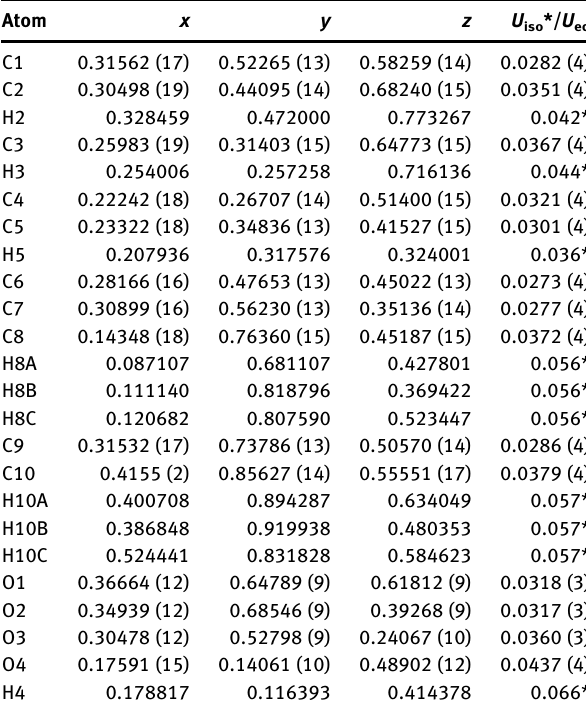
Table  : Fractional atomic coordinates and isotropic or equivalent isotropic displacement parameters (Å 